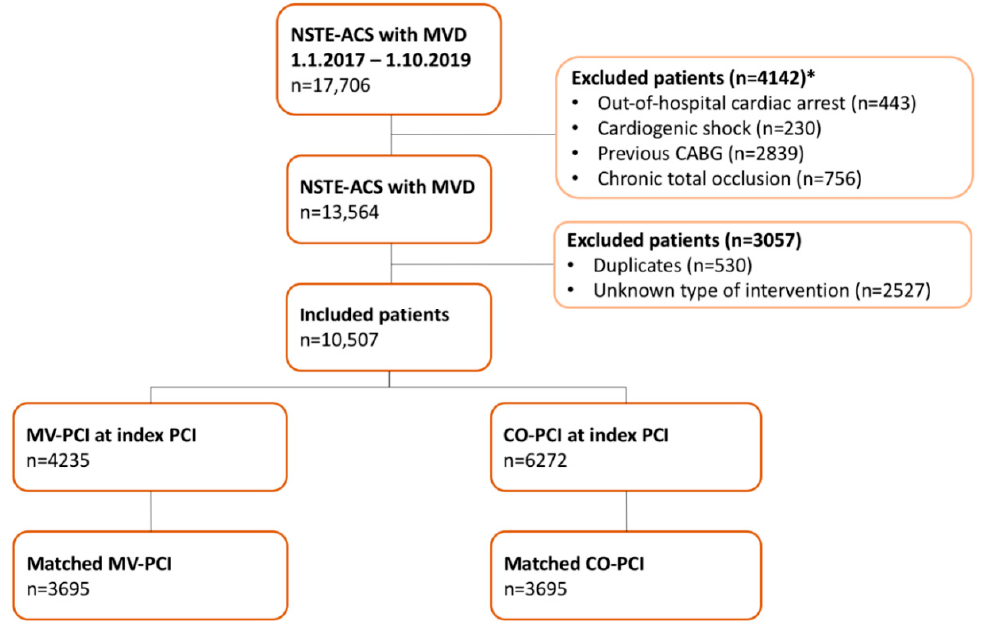
Figure 1. Flow-chart of included NSTE-ACS patients undergoing PCI. CABG, coronary artery bypass grafting; CO-PCI, culprit-only PCI; NSTE-ACS, non-ST-segment elevation acute coronary syndrome; MVD, multivessel disease; MV-PCI, multivessel PCI; PCI, percutaneous coronary intervention. * As some patients met multiple exclusion criteria, numbers do not sum to 4142.